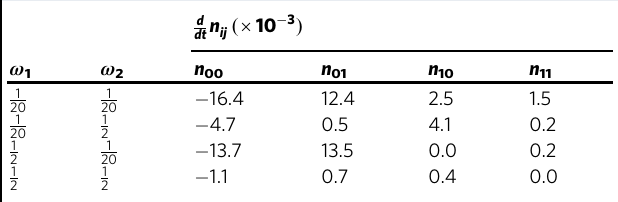
Table 1 Rate of population change for different frequencies for the local two-qubit